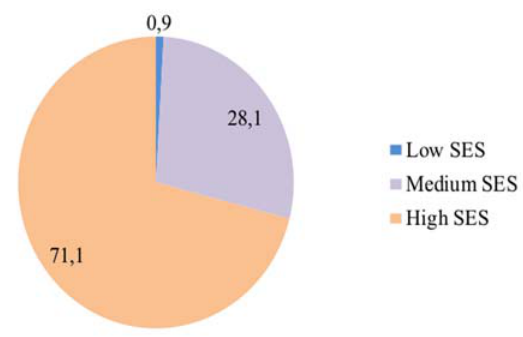
Figure 1. Distribution by SES in our student sample.